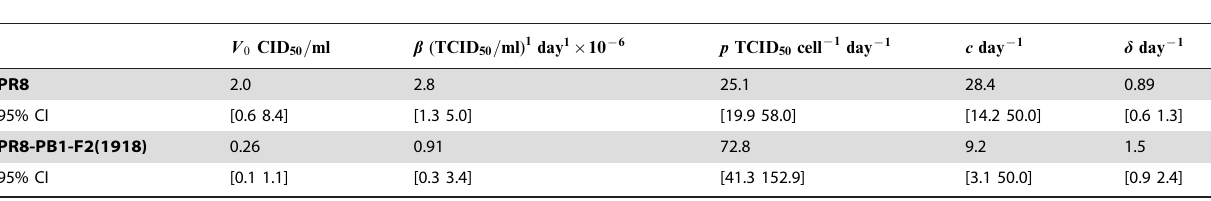
Table 2. Maximum likelihood estimates of parameter values for influenza infection with PR8 and PR8-PB1-F2(1918).